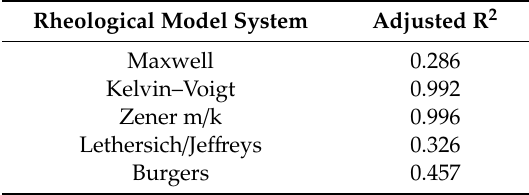
Table 8. Applicability of di ff erent rheological model systems for Elastosil